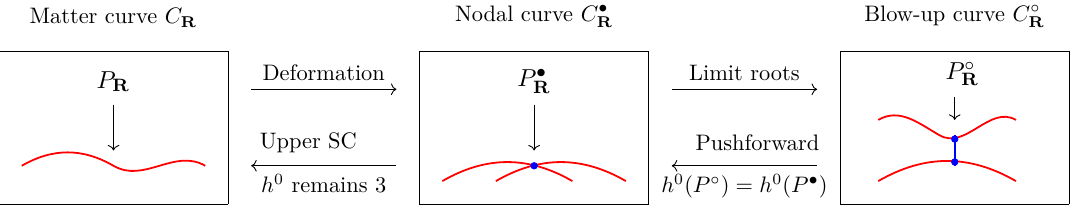
on a nodal curve C • R